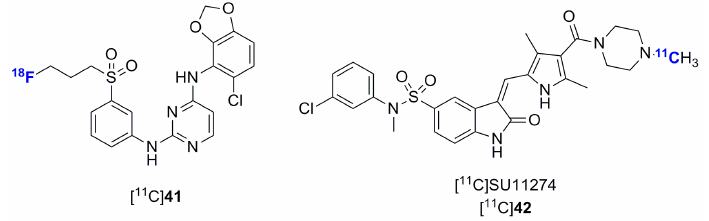
Figure 13. Chemical structures of other radiolabeled tyrosine kinase inhibitors.